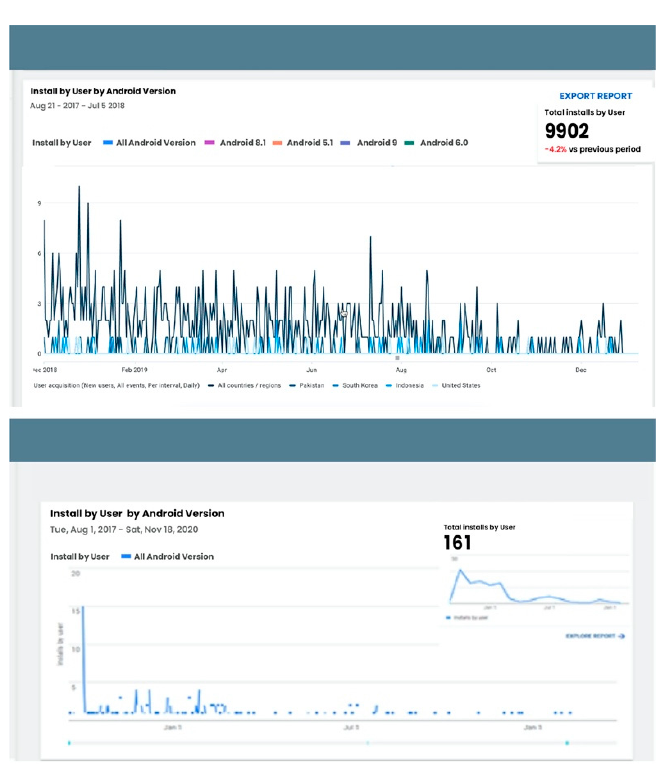
Figure 7. Account 2’s app downloads.